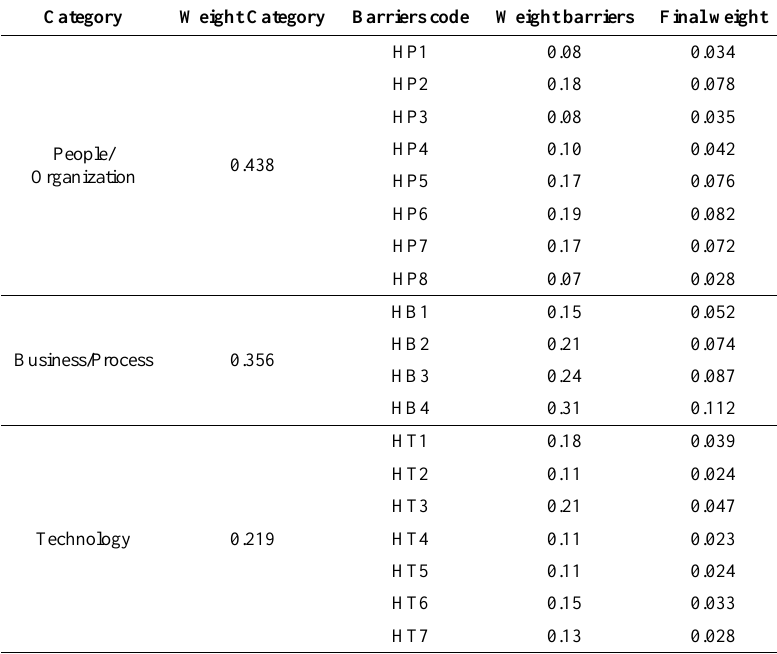
Table 8. Category and Subcategory Barrier Weight